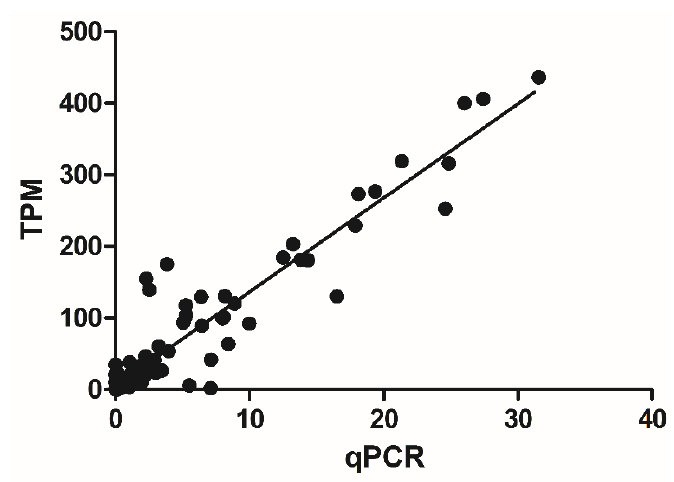
Figure 6. Correlation analysis between gene expression values obtained from RNA-seq and qRT-PCR. The value of qRT-PCR (x-axis) were plotted against RNA-seq values (y-axis).